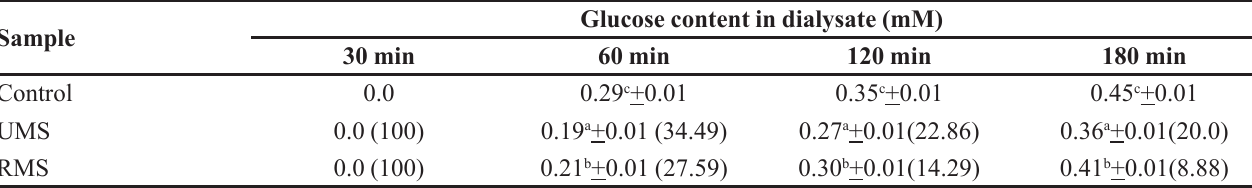
TABLE II - Effect of selected samples on starch digestibility and glucose dialysis retardation index